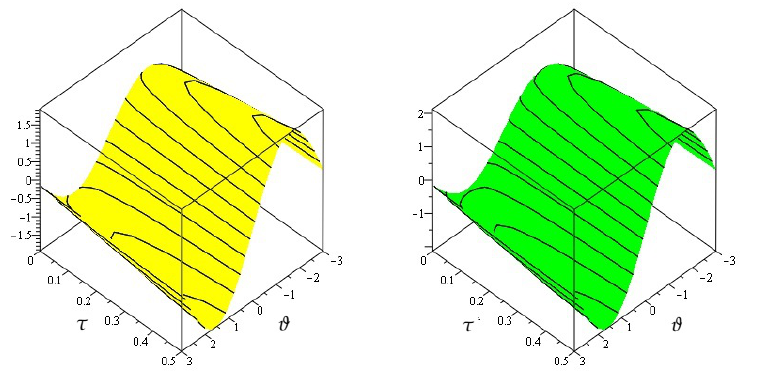
Figure 11. The analytical solutions of ν ( ϑ , ζ , z , τ ) at (cid:36) = 0.6 and 0.4 of Example 3.